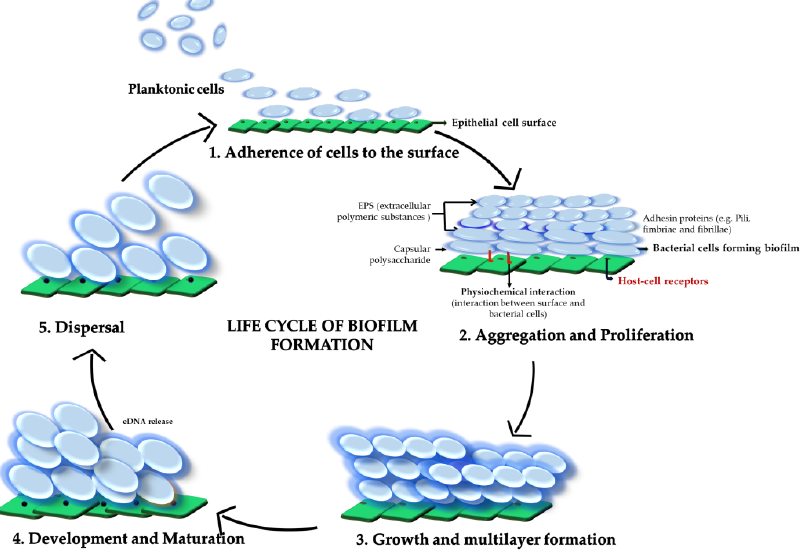
Figure 1. Schematic diagram representing the life cycle of biofilm formation in Streptococci. The diagram shows the transition of planktonic cells to sessile cells by undergoing different stages of biofilm formation and repeating the cycle by the conversion of sessile cells to the planktonic state again.